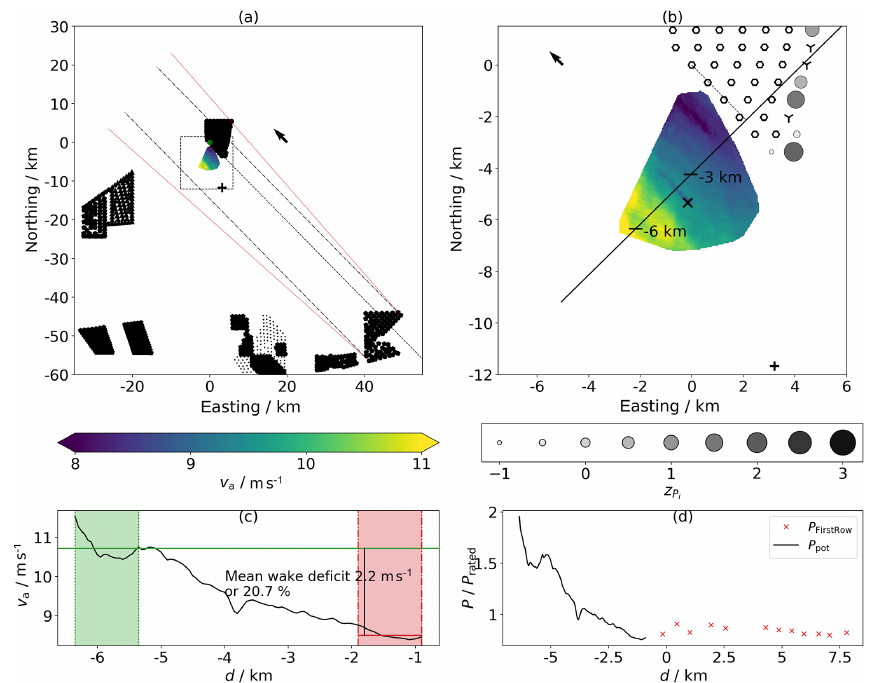
Figure 11. Wake of the DolWin2 cluster on 11 October 2018 as in Fig. 6 but averaged over 16 consecutive lidar scans (scan scenario A) in a period of 162min (15:44–18:26UTC); power data of upstream turbines averaged over 170min (15:40–18:30UTC); downstream turbines marked (hexagon). Turbine numbers to calculate the z score are 8, 15, 22, 29, 36, 43, 50, 68, 72, 78, 80, and